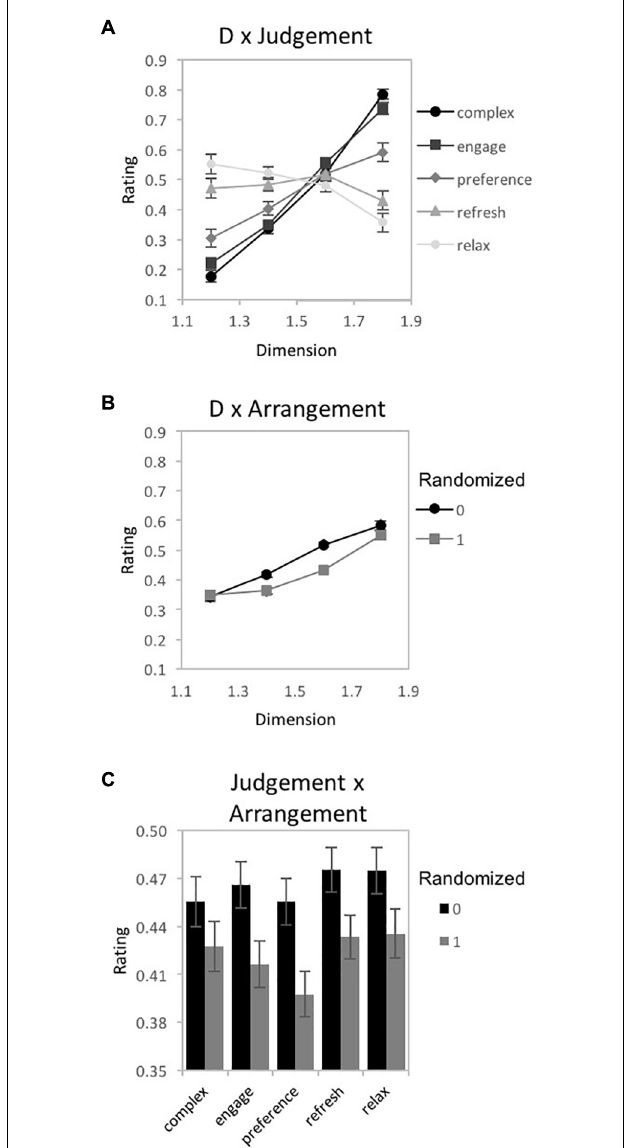
FIGURE 6 | Experiment 1A results for “global forest” fractal patterns using a unipolar rating scale. Results show significant 2-way interactions among the experiment’s 3 factors: fractal dimension ( D ), stimulus pattern arrangement (“0” for non-randomized and “1” for randomized), and judgment